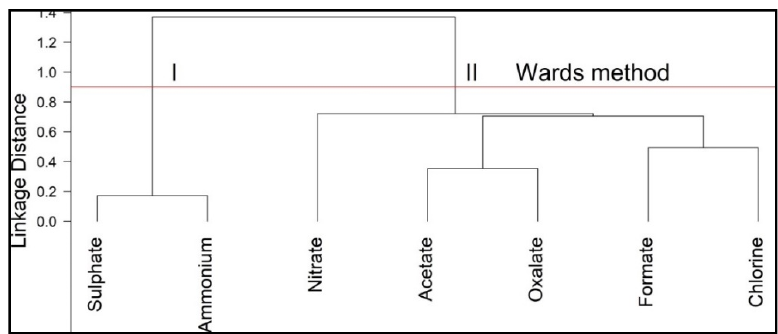
Figure 5. Results of the hierarchical cluster analysis (dendrogram) of the water ‐ soluble ions concentrations measured in PM 2.5 .